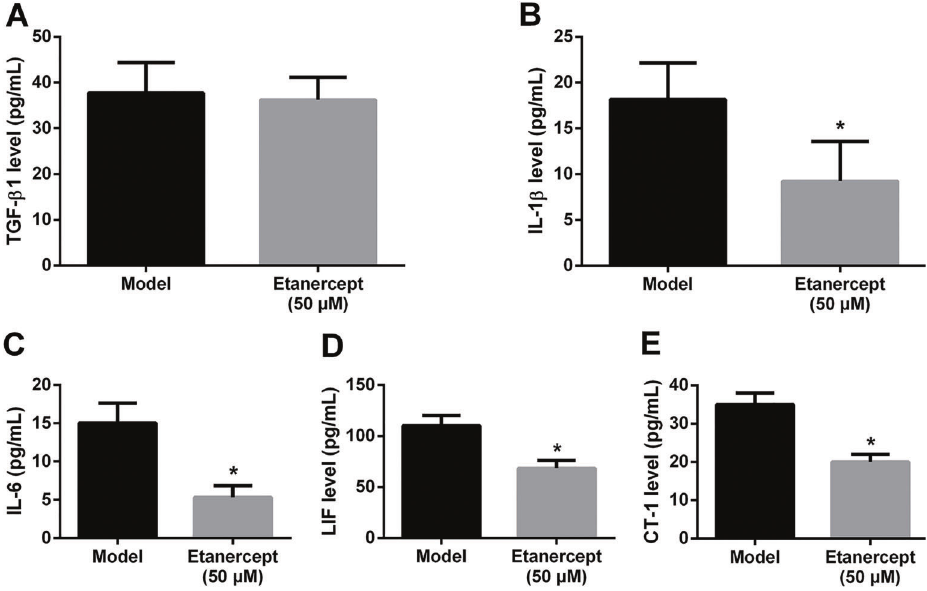
Figure 4. Transforming growth factor- b 1 (TGF- b 1, A ), interleukin (IL)-1 b ( B ), IL-6 ( C ), leukemia inhibitory factor (LIF, D ) and cardiotrophin (CT)-1 ( E ) in cardiomyocytes with endothelin-induced hypertrophy and then treated with 0 or 50 m M etanercept evaluated using enzyme linked immunosorbent assay. Data are reported as mean ± SD. *P o 0.05 compared with model